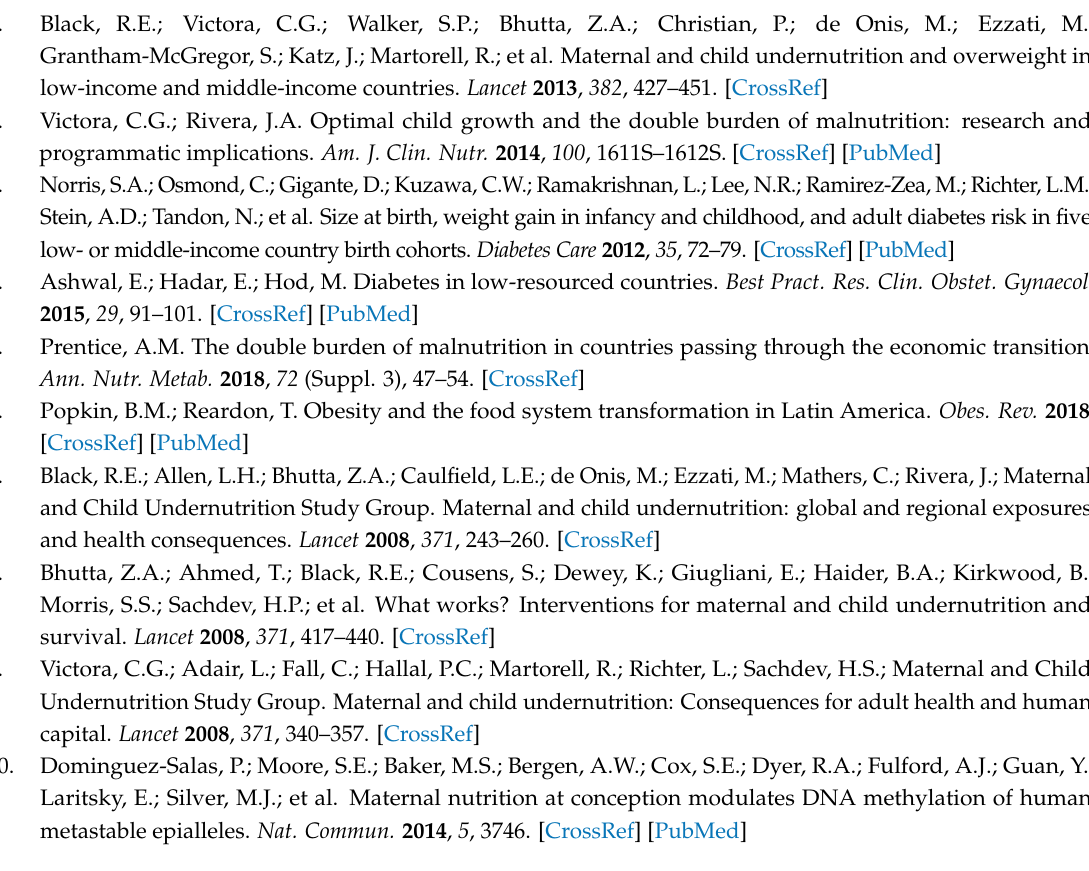
s1, Table S1: Nutrient Content of the Lipid-based Micronutrient Supplement (20 g), Table S2: Regression analysis of leptin, adiponectin, insulin, and other amino acids in relation to maternal pre-pregnancy body mass index (ppBMI), taken at 12 weeks (12 weeks) gestation. Table S3: Correlations between branched chain amino acids ± LNS and serum parameters and other amino acids at 12 weeks